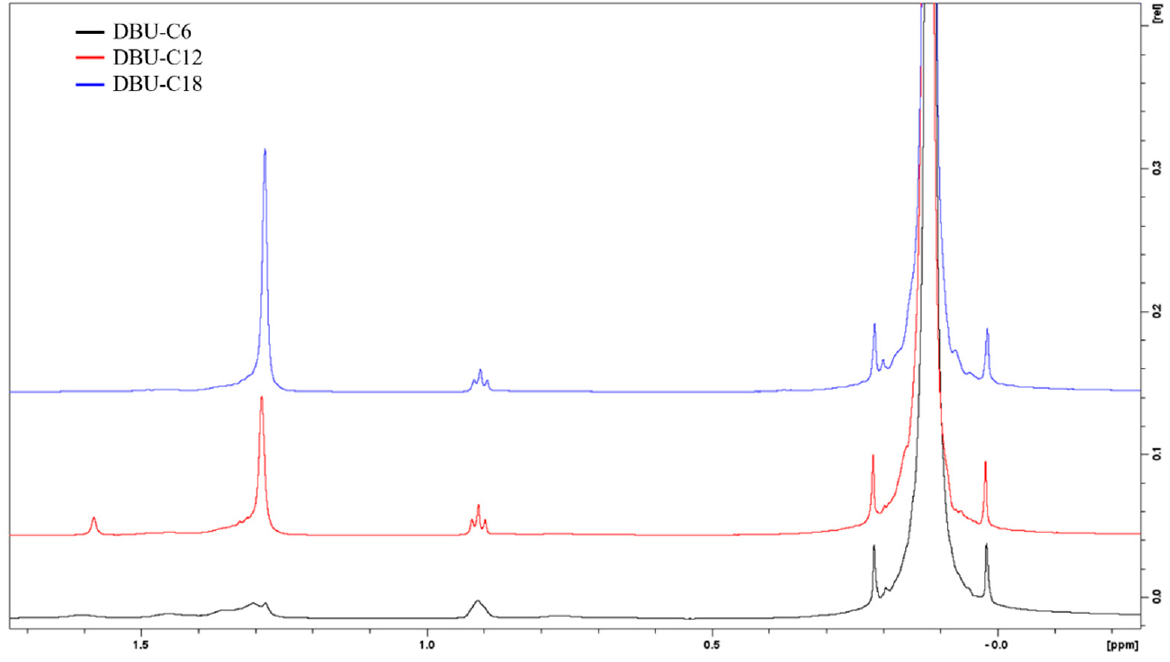
Figure 5. 1 H NMR spectra of C6 ( bottom ), C12 ( middle ), and C18 ( top ) silanized silica. Quantitative results from TGA and 1 H NMR are displayed in Table 2 and Figure 6. It must be noted that TGA values are always higher than the corresponding 1 H NMR values.